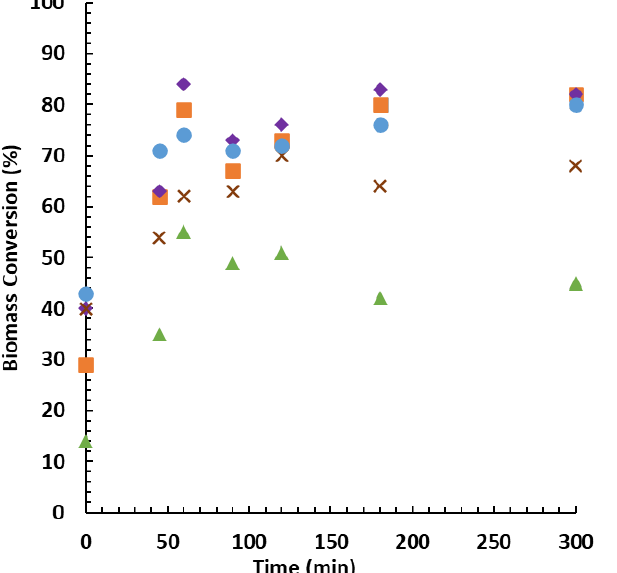
Figure 3. Biomass conversion rates by reaction time for each feedstock type: bark ( (cid:78) ), heartwood ( (cid:7) ), sapwood ( (cid:4) ), pinewood ( • ), and branches ( × ).